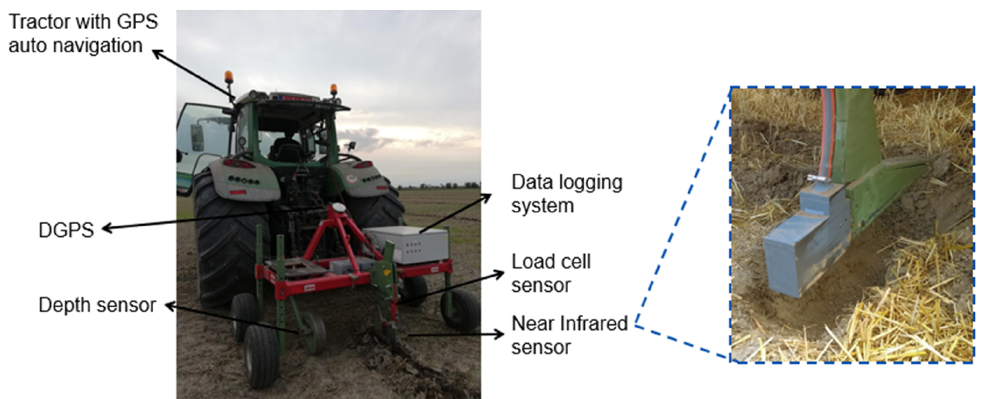
Figure 3. The multiple-sensor platform used for collecting soil data. DGPS: differential global positioning